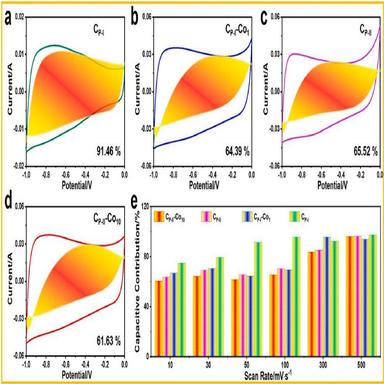
The capacitance ratio of each sample at 50 mV•s − 1 : a) CP-I, b) CP-I-Co1, c) CP-II, and d) CP-II-Co10; e) the capacitance ratio of samples at different scan rates.